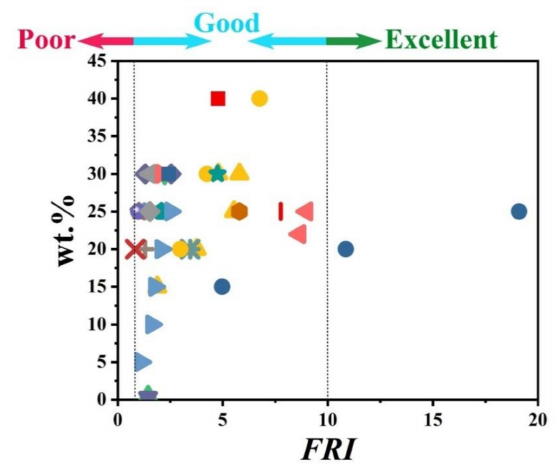
Figure 4. FRI values as a function of nitrogen FR type and content. Symbols are indicative of di ff erent types of nitrogen flame retardant used. Here: (cid:4) MP-40 [63],